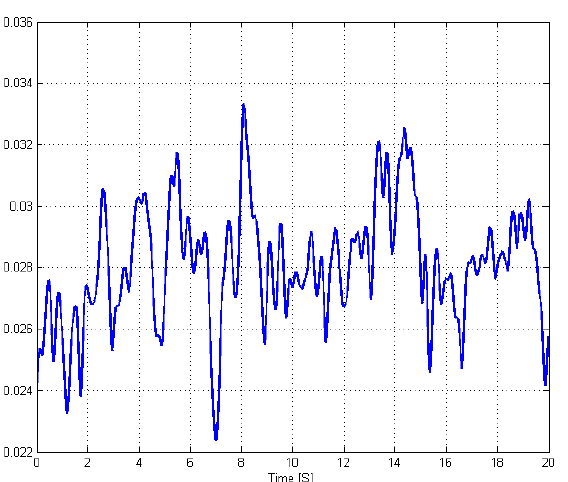
Figure10. The profile of wavelet scalogram related to rates of turn around flight direction at 12